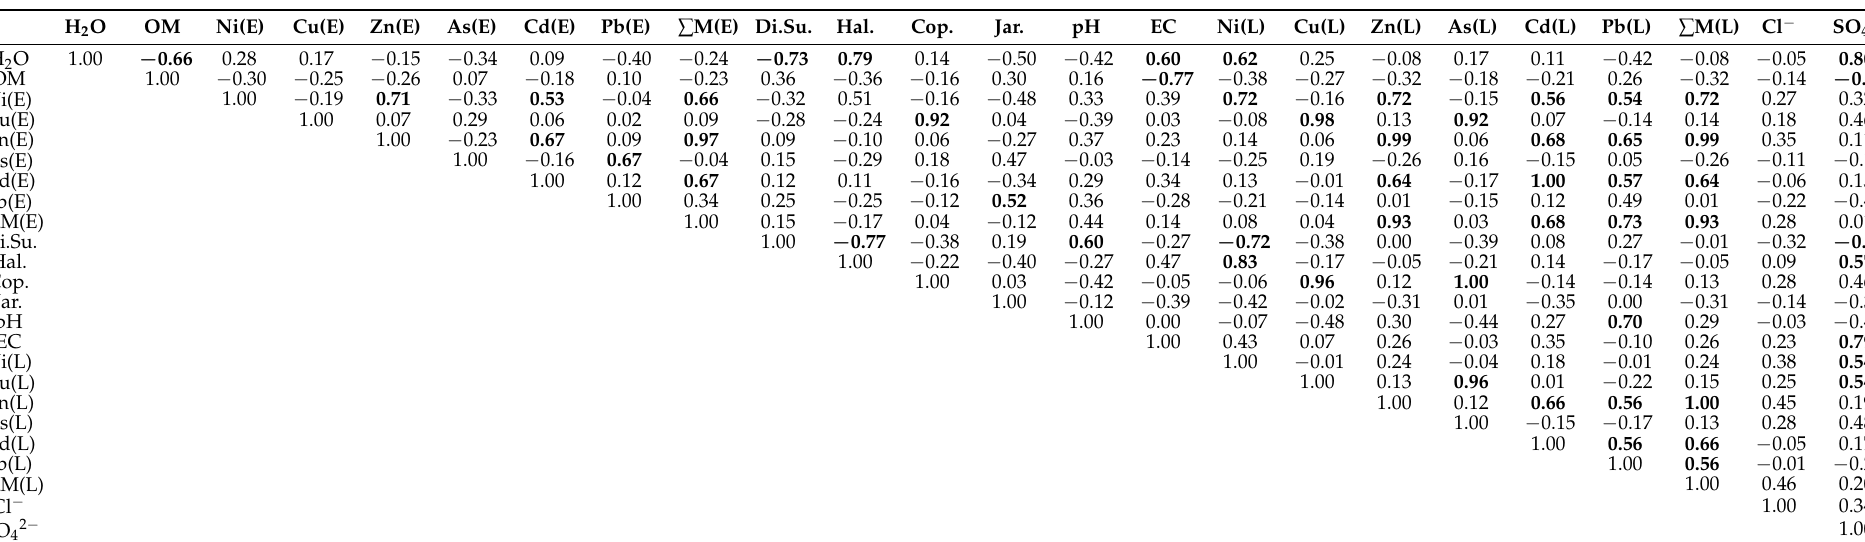
Table 5. Correlation matrix of salt efflorescences (E) and their leachates (L). Significant correlations at the 0.05 level are shown in bold. (H 2 O is the water content and OM stands for organic matter, both determined by thermogravimetry (TG-MS); E = Salt efflorescence in solid form; L = leachate of salt efflorescence; ∑ M = sum of the metal(loid)s considered); Di.Su. = divalent metal(loid) sulphate minerals; Hal. = halotrichite group minerals; Cop. = copiapite group minerals; Jar. = jarosite group